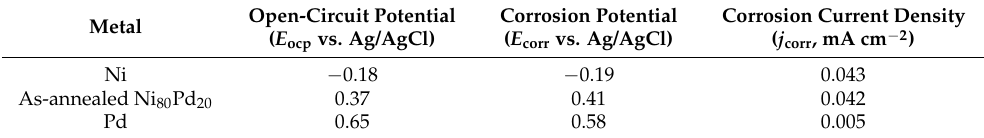
Figure 5. ( a ) Open-circuit potentials of Ni, Ni 80 Pd 20 and Pd versus time. ( b ) Polarization plots of the Ni, Ni 80 Pd 20 , and Pd at the scan rate of 1 mV s − 1 . ( c ) Dealloying potential versus time, and the insets present the photos of the as-annealed alloy and bulk np-Pd. The variation of current density ( j ) and charge ratio ( Q t /Q ) with respect to time during ( d ) the first-step and ( e ) the second-step dealloying. Table 1. The electrochemical activities of the Ni, Ni 80 Pd 20 and Pd in the 0.5 M H 2 SO 4 solution.